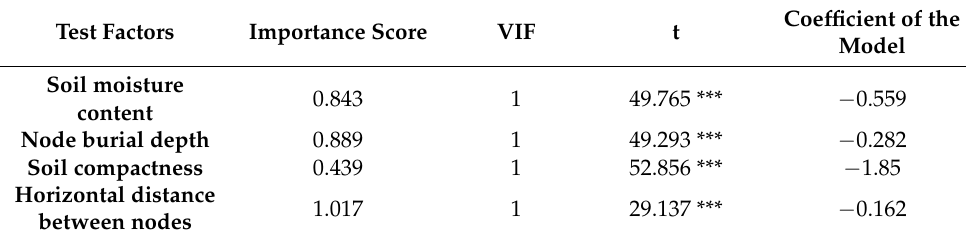
Table 2. Regression results of the